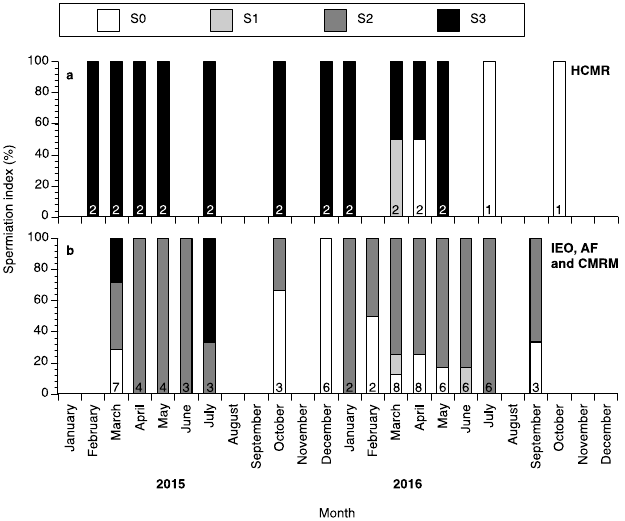
Figure 5. Male wreckfish at different spermiation index stages in HCMR, Greece ( a ) and in the three broodstocks in Spain ( b ) between February 2015 and October 2016. Spermiation index S0 = no milt released, S1 = only a drop of milt released after multiple stripping attempts, S2 = milt was released easily after the first stripping attempt and S3 = milt was fluently released even without abdominal pressure. The numbers inside the bars indicate the number of males examined each month.